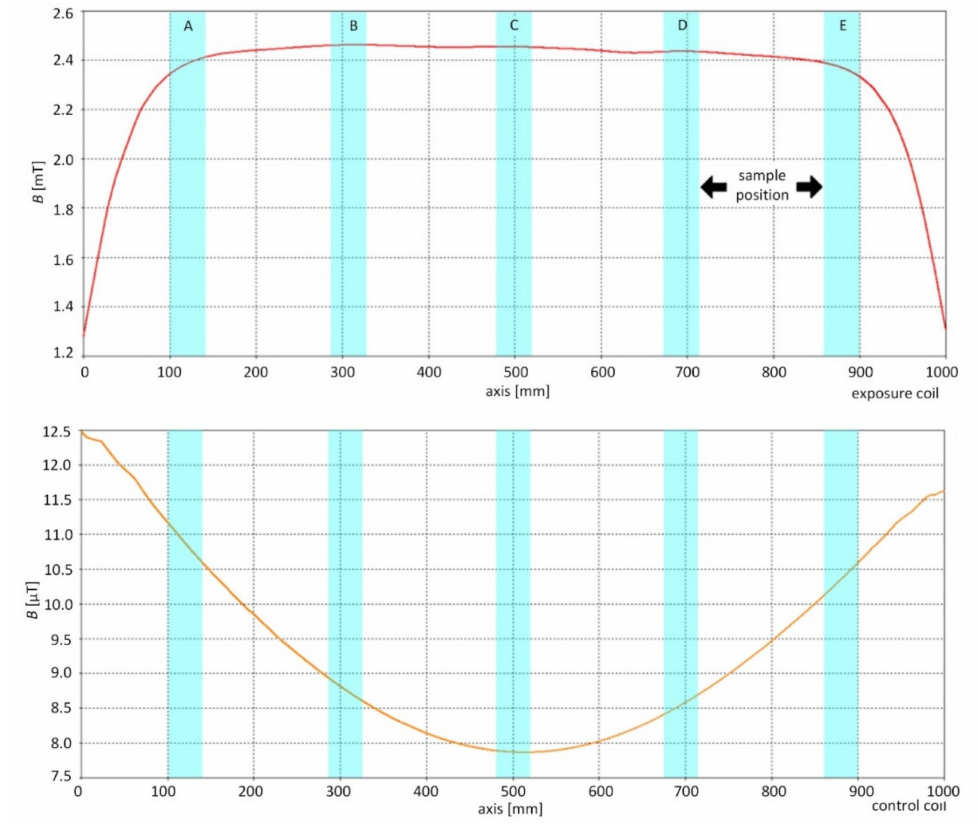
Figure 3. Magnetic flux density distribution along the axis for exposure and control coil, data from CST Studio